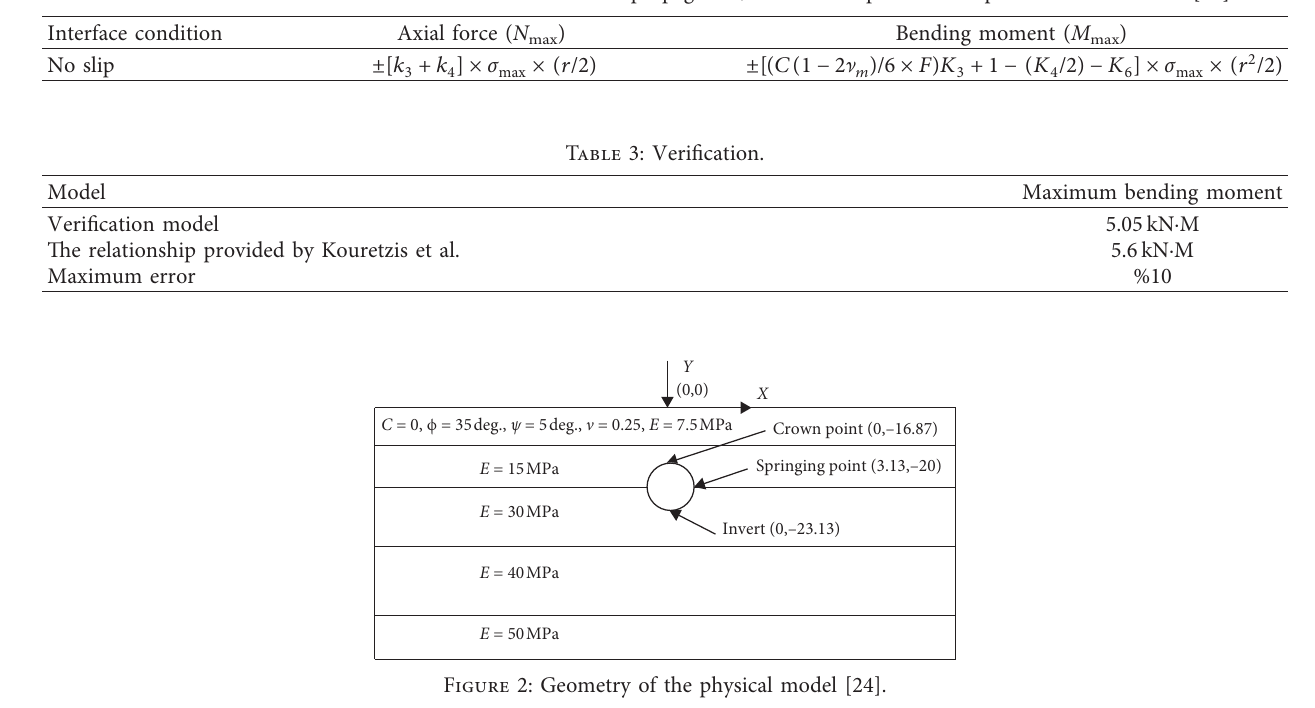
Table 2: Internal forces of a circular liner due to P-wave propagation, under no-slip and full-slip interface conditions